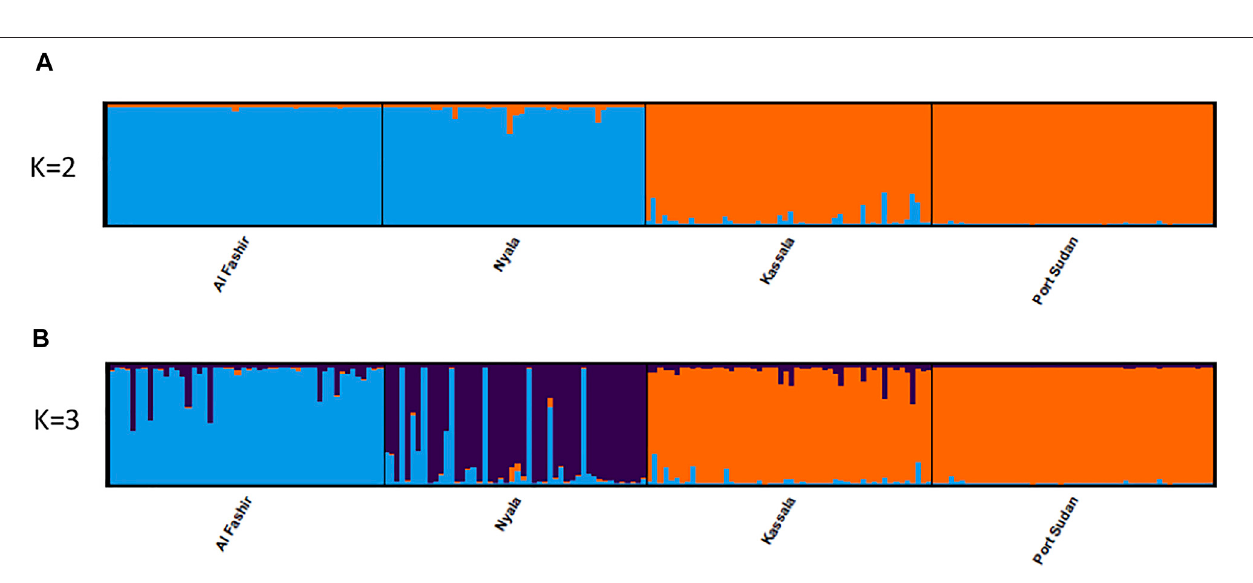
FIGURE2| Geneticstructureof Ae.aegypti Sudanpopulations.STRUCTUREbarplotindicatinggeneticgroupingsoffourgeographiclocationsinSudanbasedon 12 microsatellite loci. Each vertical bar represents an individual. The height of each bar represents the probability of assignment to each of K = 2 (A) and of K = 3 (B) clusters as determined using the Delta K method. Each cluster is indicated by different